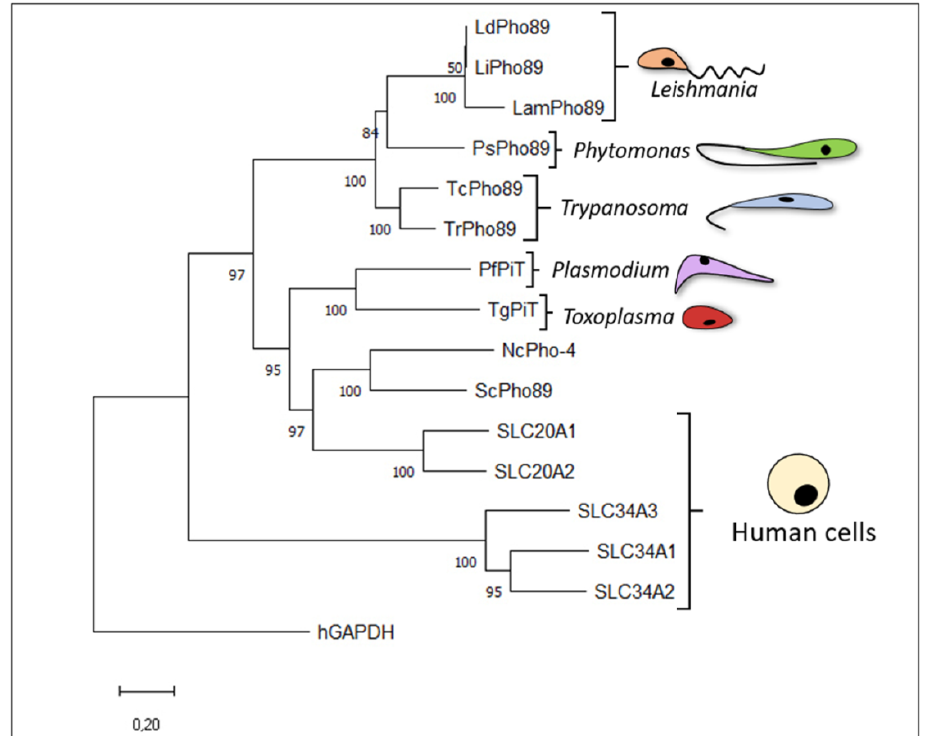
Figure 2. Evolutionary relationships of Na + :Pi transporters from the PiT family. The evolutionary history was inferred using the neighbour-joining method [54]. The optimal tree is shown. The percentages of replicate trees in which the associated taxa clus- tered together in the bootstrap test (1000 replicates) are shown below the branches [55]. The tree is drawn to scale, with branch lengths shown with the same units as those of the evolutionary distances used to infer the phylogenetic tree. The evolutionary distances were computed using the Poisson correction method [56] and are presented in terms of the number of amino acid substitutions per site. This analysis involved 18 amino acid se- quences. All ambiguous positions were removed for each sequence pair (pairwise deletion option). A total of 754 positions were included in the final dataset. Evolutionary analyses were conducted using MEGA11 [57]. The PiT family members (with their respective Gen- Bank information) are as follows: LdPho89 from Leishmania donovani (GenBank: CBZ35792.1 [20]); LiPho89 from L. infantum (GenBank: JQ660321 [16]); LamPho89 from L. amazonensis (GenBank: LAMA_000122100 [21]); PsPho89 from Phytomonas serpens (Gen- Bank: CCW59586.1 [18]); TcPho89 from Trypanosoma cruzi (GenBank: XP_813912.1 [6]); TrPho89 from T. rangeli (GenBank: TRSC58_00347 [5]); PfPiT from Plasmodium falciparum (GenBank: CAE30463.1 [14]); TgPiT from Toxoplasma gondii (GenBank: TGGT1_240210 [23]); NcPho-4 from Neurospora crassa (GenBank: AAA33607.1 [58]); ScPho89 from Saccha- romyces cerevisiae (GenBank: NP_009855.1 [53]); SLC20A1 and SLC20A2 from humans (GenBank: NP_005406.3 and NP_006740.1, respectively [32]); and SLC34A3, SLC34A1, and SLC34A2 from humans (GenBank: NP_543153, AAA36354, and AAF31328, respec- tively [30]). Outgroup: human hGAPDH (GenBank: NP_002037.2). 2.1. Cancer cells Vertebrates have evolved two distinct isoforms, SLC20A1 and SLC20A2, and each genome normally contains one gene encoding each isoform. The identification of both SLC20A mRNAs indicates widespread SLC20A expression and suggests a housekeeping